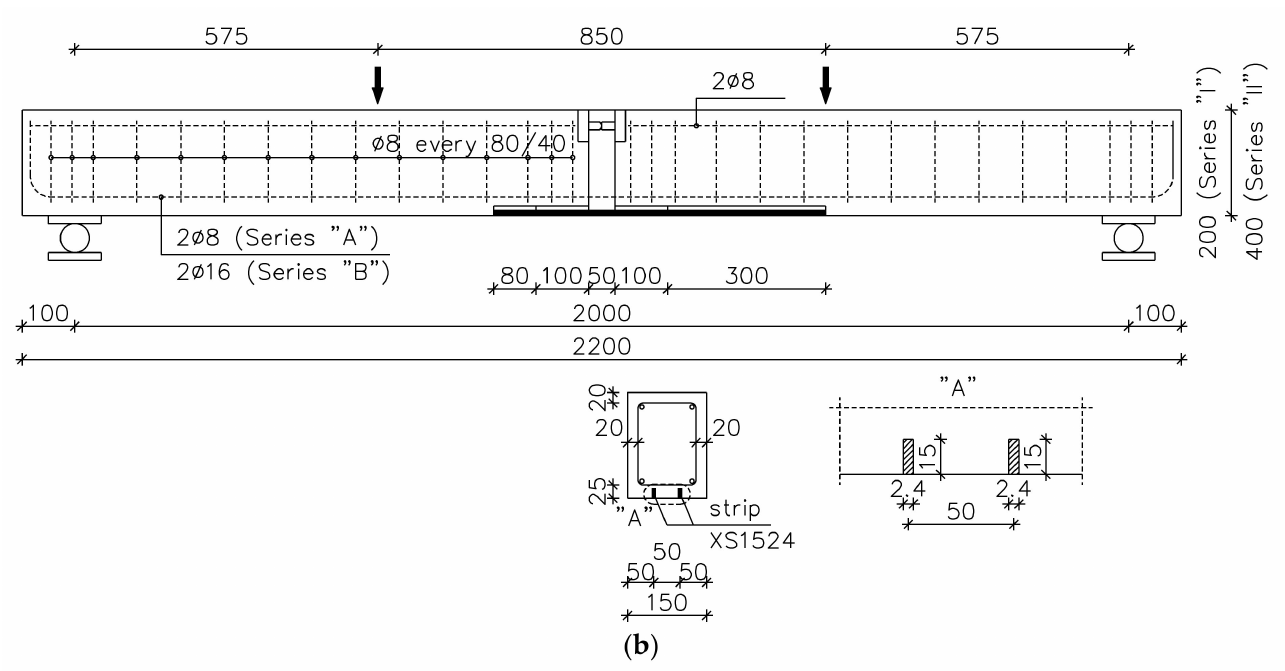
Figure 1. Dimensions (in mm), steel reinforcement and modes of strengthening: ( a ) short—S; ( b ) long beam specimens—L [48].